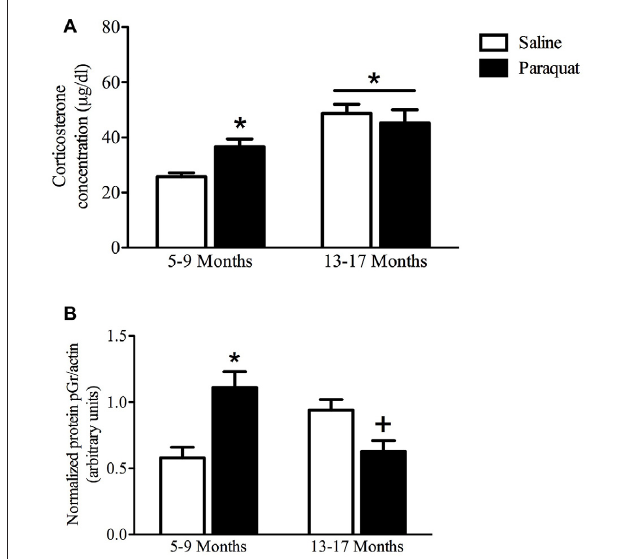
FIGURE 8 | Plasma corticosterone and hippocampal pGR protein as a function of age and long-term (low dose) paraquat treatment. As shown in (A) , the older cohort (13–17 months) displayed elevated corticosterone levels (collapsed over paraquat treatment). Paraquat treatment elevated corticoid levels; but interestingly, this effect was restricted to the younger cohort (5–9 months). ∗ p < 0.05 relative to the saline treated younger cohort. As displayed in (B) , paraquat robustly increased hippocampal protein levels of pGR in the younger cohort in comparison to age matched saline treated mice, however, it significantly reduced levels in mice from the older cohort, relative to their saline injected counterparts. ∗ p < 0.05 relative to saline treated mice from the younger cohort, + p < 0.05 relative to saline treated mice form the older